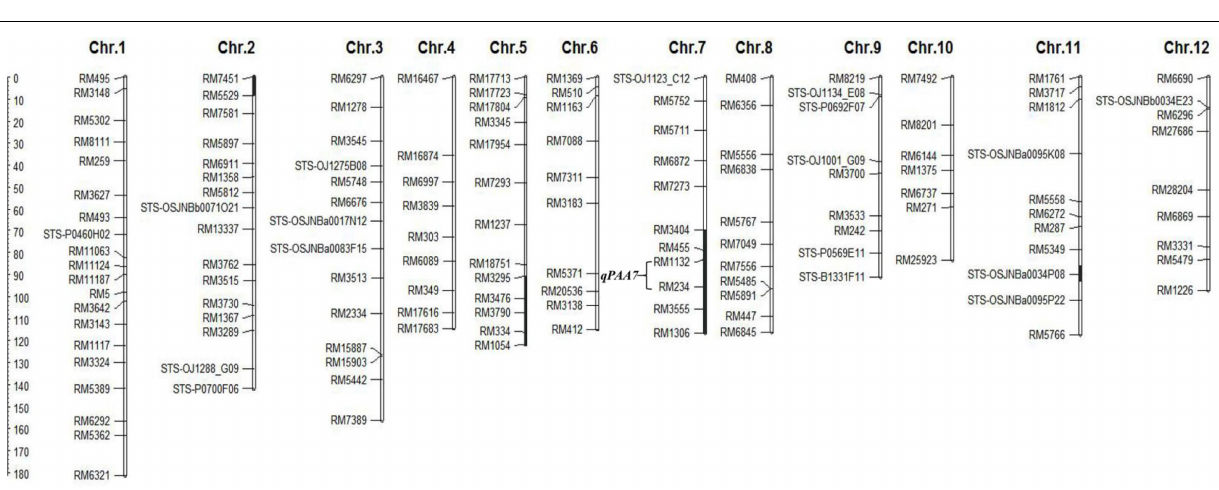
CSSLs, CSSL15, CSSL176, CSSL205, CSSL207 and CSSL208 lines harbors qPAA7 and showed aborted spikelets at the apical portion of panicle at the heading stage ( Table 4